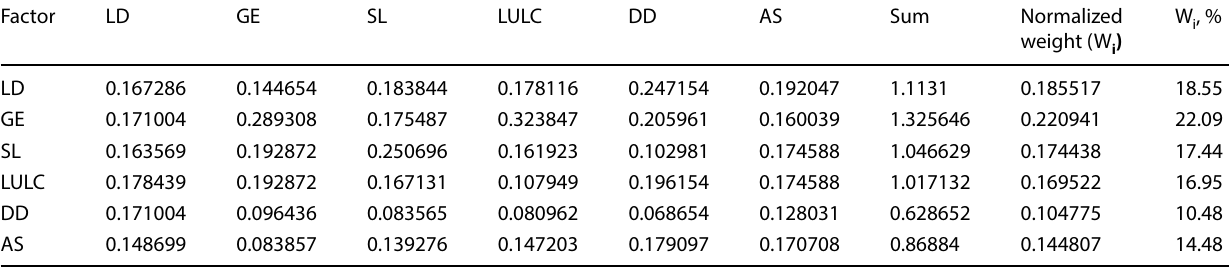
Table 3 Normalize pair-wise matrix showing normalized AHP weights (W value of 1.37 (i.e. n = 6 in Table 3 above)